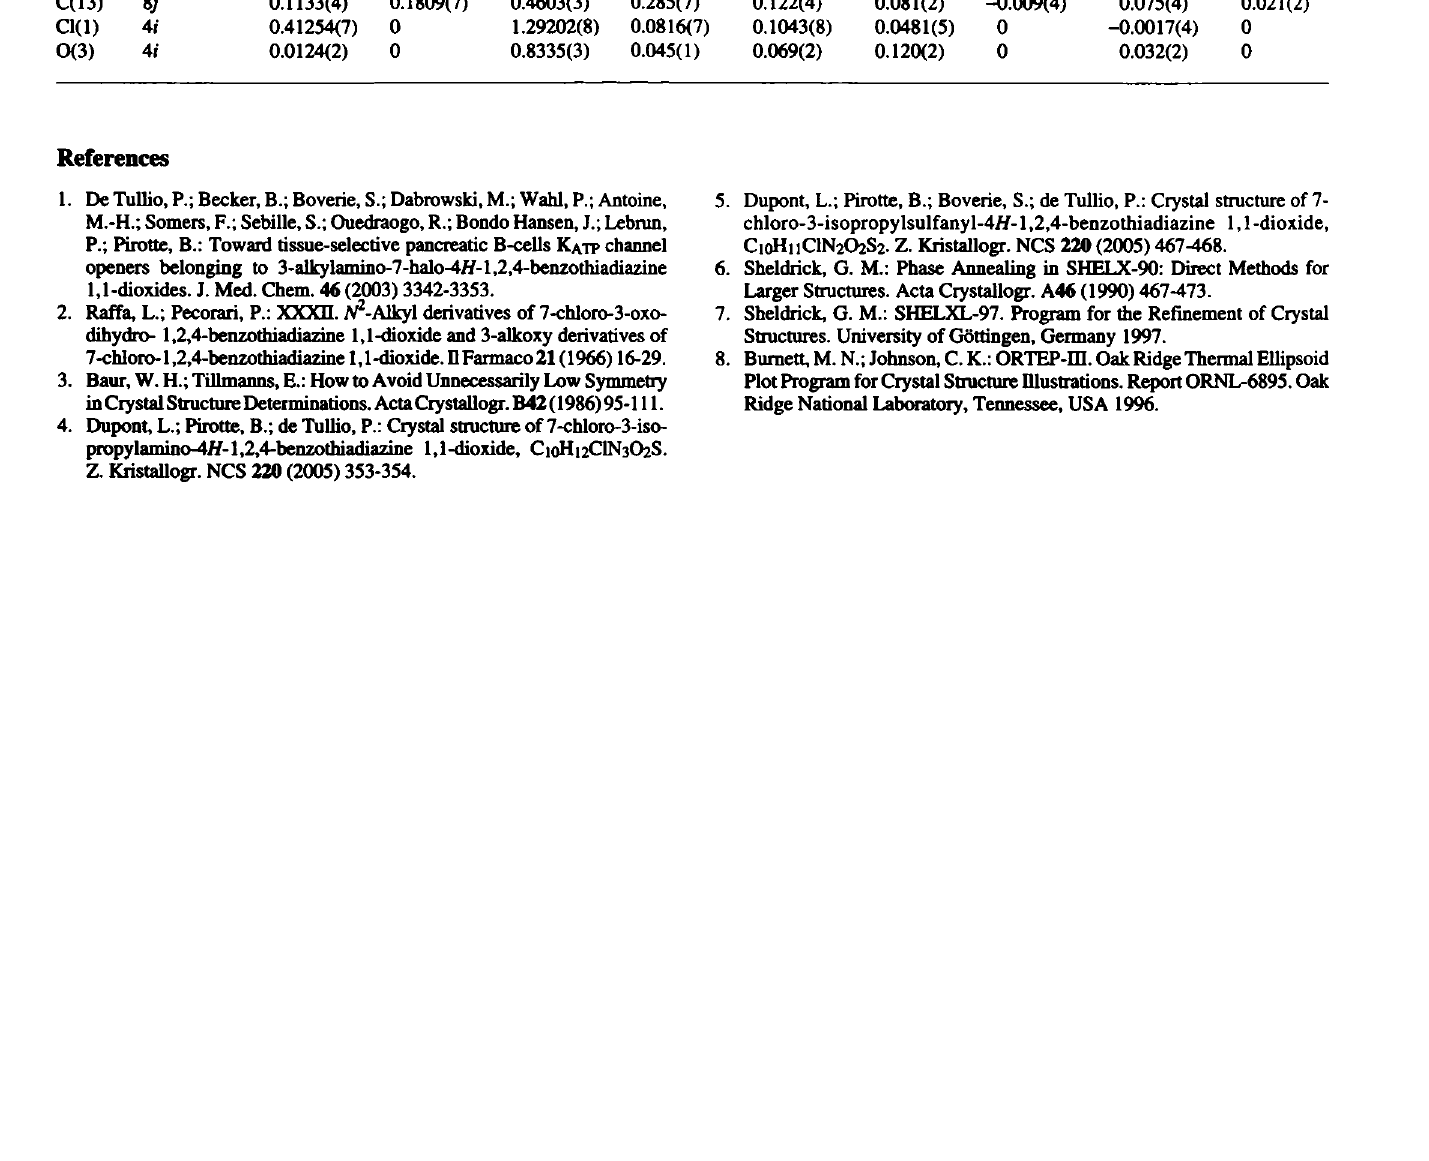
Table 3. Atomic coordinates and displacement parameters (in A 2